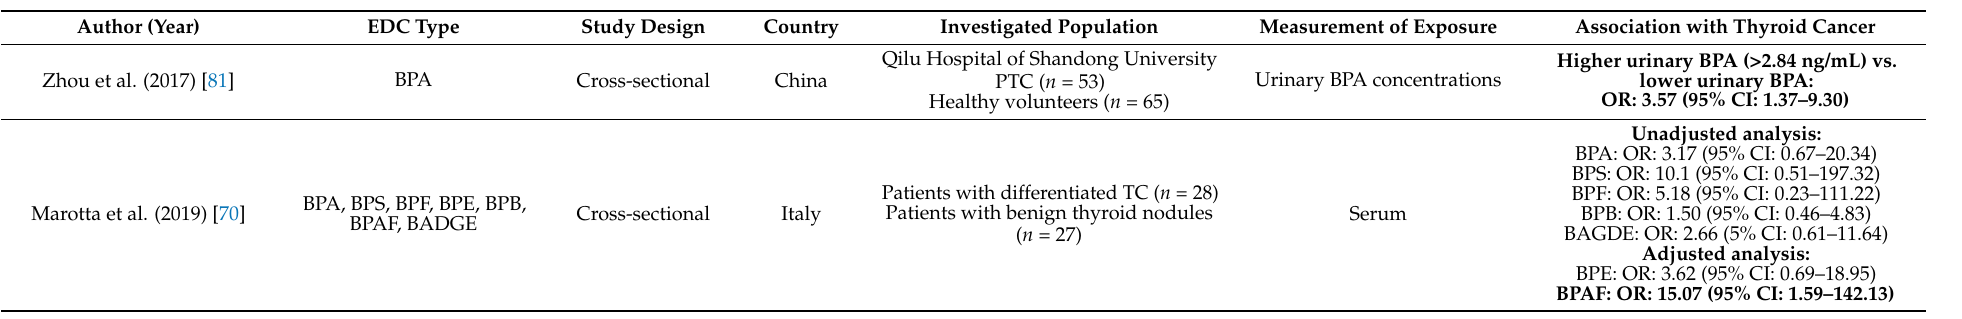
Table 4. Association between exposure to BPA and thyroid cancer. Abbreviations: BPA: bisphenol A; BADGE: Bisphenol A diglycidyl ether; BPAF: Bisphenol AF; BPB: Bisphenol B;